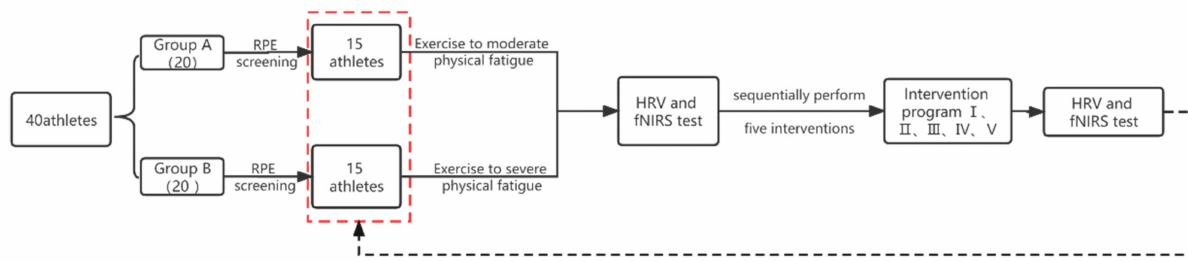
Figure 2. Experimental testing